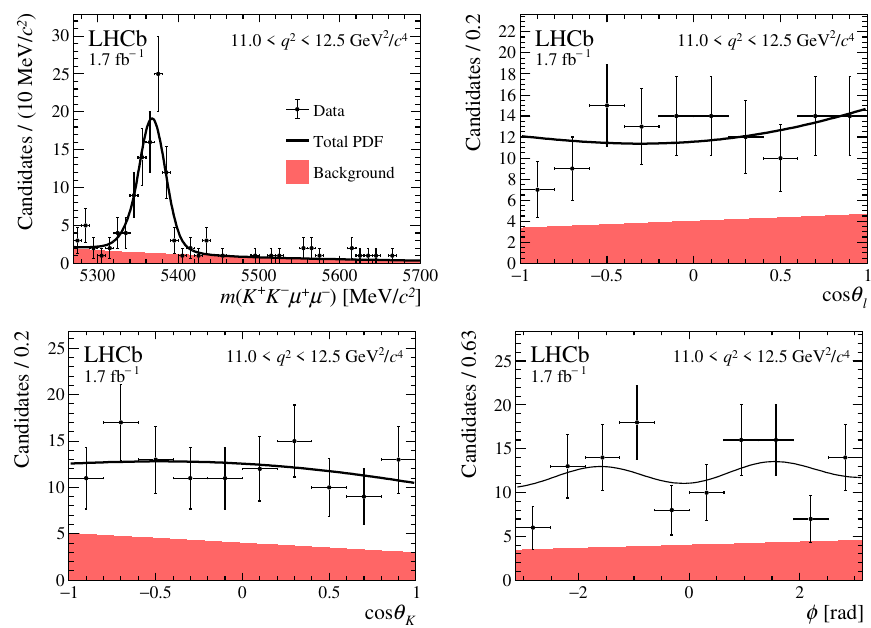
Figure 25 . Mass and angular distributions of B 0 11 . 0 < q 2 < 12 . 5 GeV 2 /c 4 for data taken in 2016. The data are overlaid with the projections of the fitted